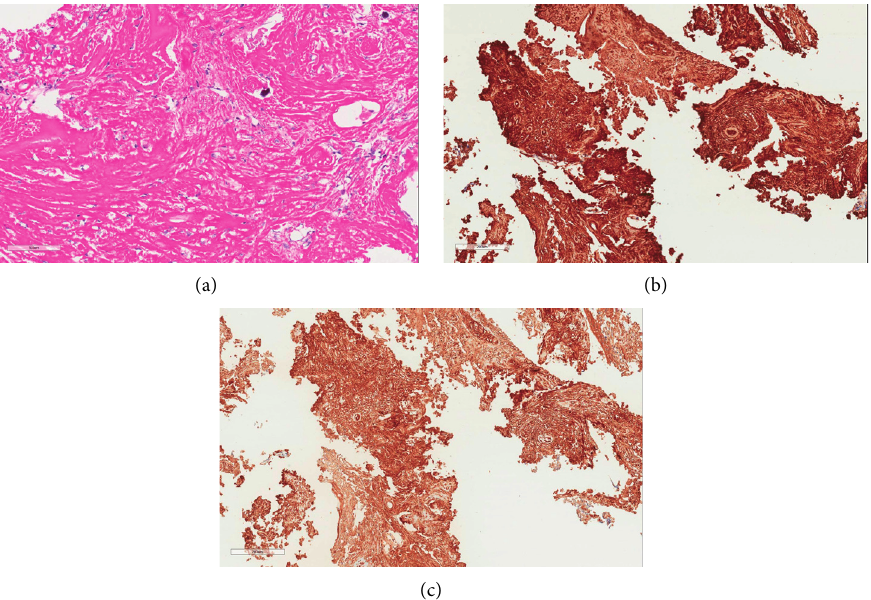
Figure 5: Computed tomography- (CT-) guided lung biopsy (Case 3). Hematoxylin and eosin stain (a) demonstrates amorphic eosinophilic material reminiscent of an amyloid process, whereas both kappa staining (b) and lambda staining (c) demonstrate mixed light chain